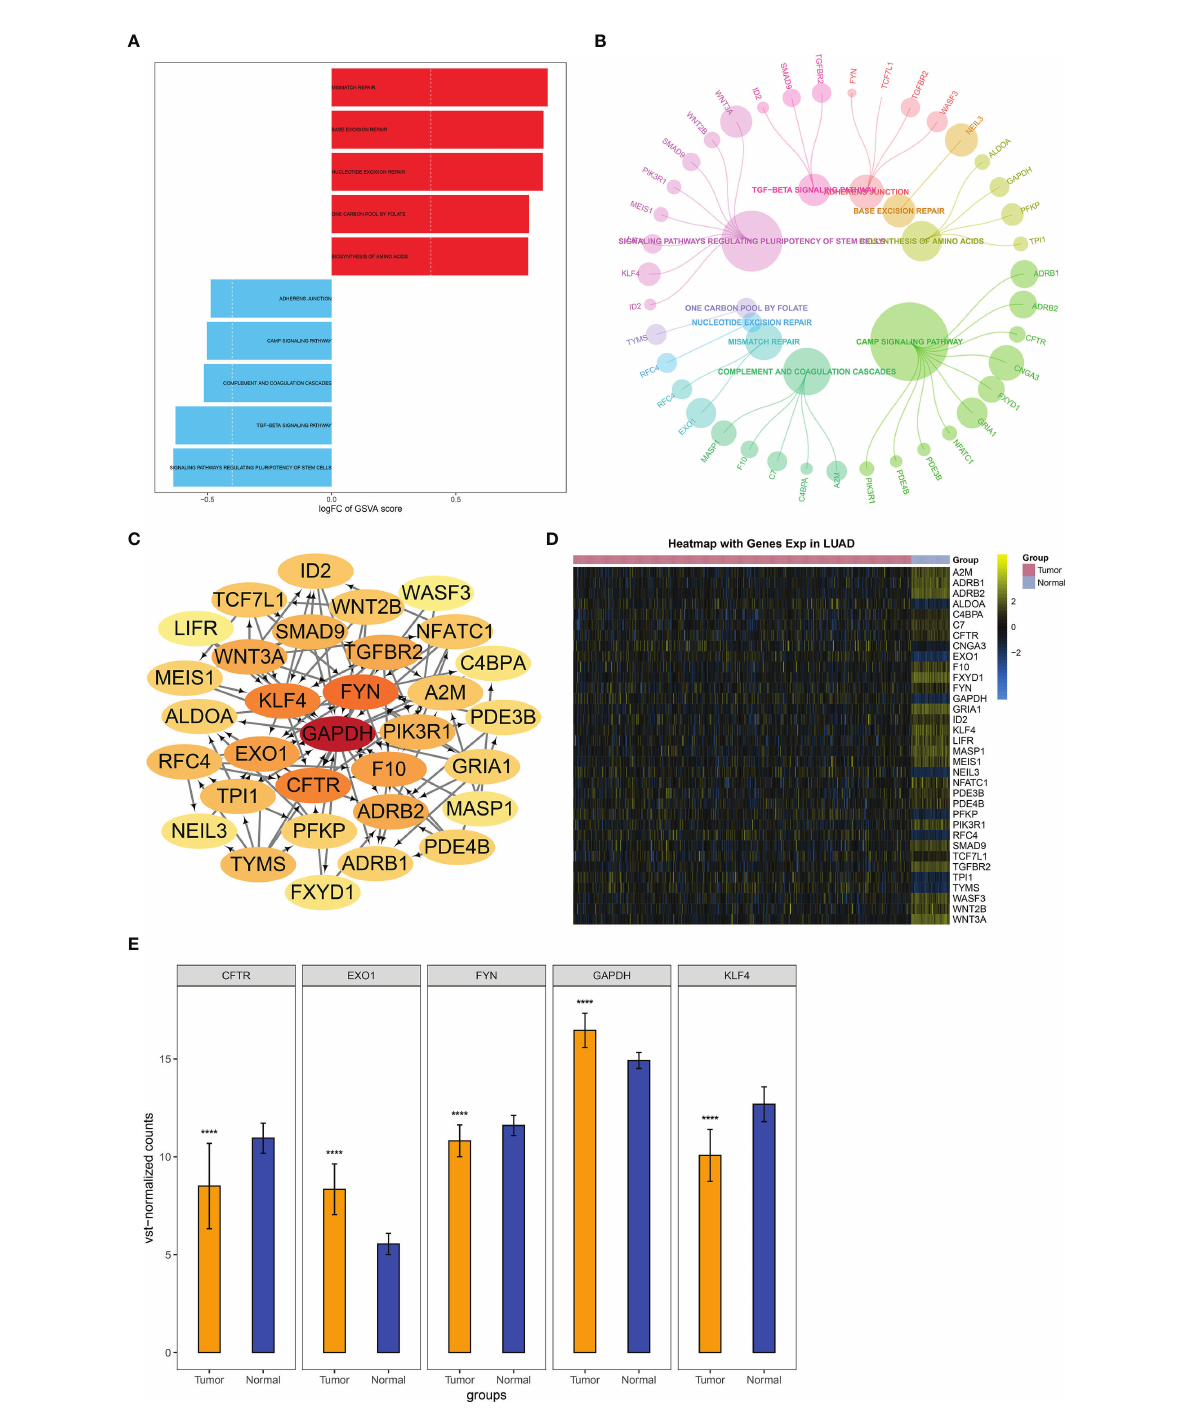
FIGURE 5 Identi fi cation of key module genes in LUAD. (A) GSVA of the major pathways enriched by genes in two key modules MEturquoise and MEblue. (B) Module genes are involved in the major pathways. (C) Selection of key module genes via PPI network. (D) Heatmap of the expression and methylation of genes from the PPI network in LUAD and normal lung tissues. (E) Expression of key module genes in LUAD and controls. ****p < 0.0001. LUAD, lung adenocarcinoma; GSVA, gene set variation analysis; PPI, protein – protein